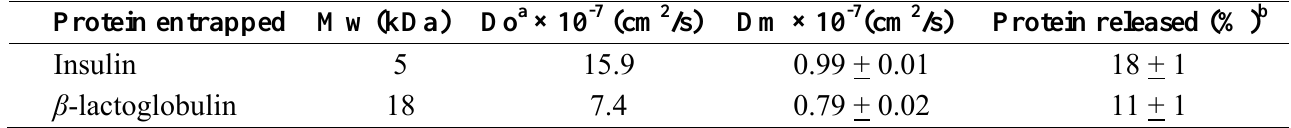
Table 1. Release parameters of insulin and β -lactoglobulin from MBAX